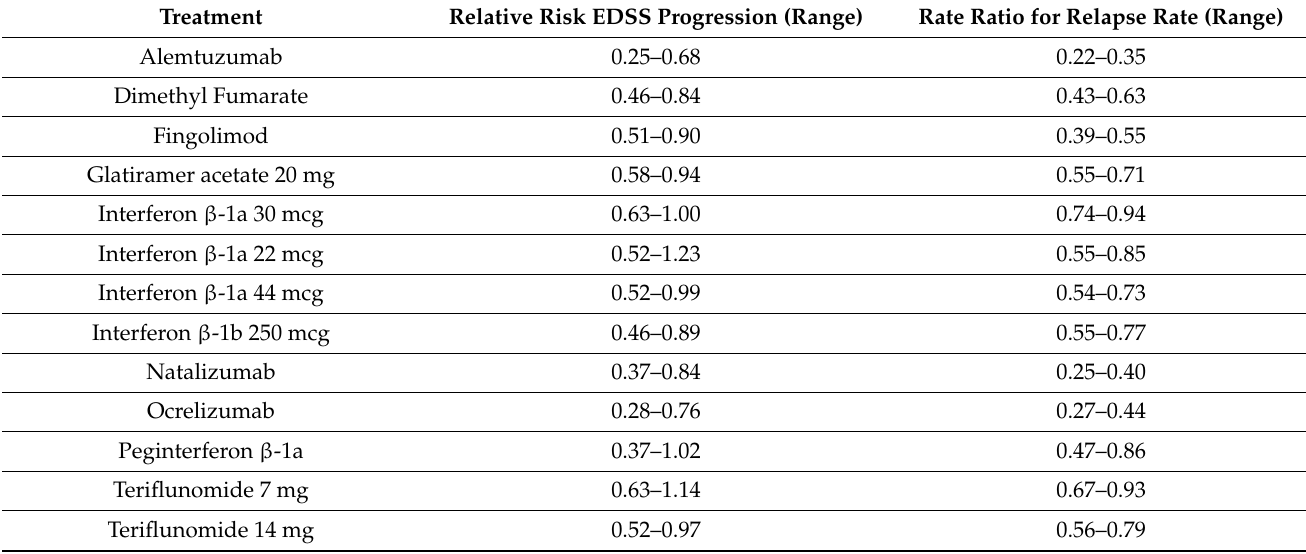
Table A4. Treatment effect parameters for individual